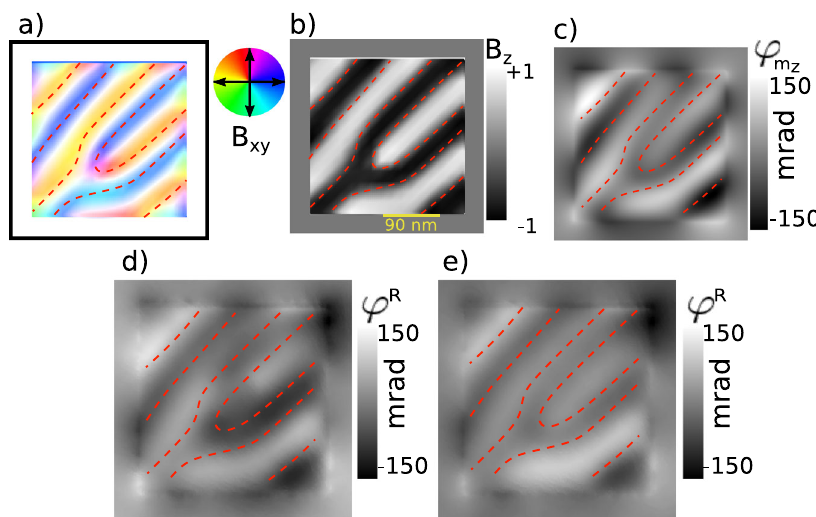
Fig. 4 Reconstruction of the phase shift resulting from the out-of-plane magnetic induction in a simulated sample with multiple domains. a The direction of in-plane magnetic induction, B xy , indicated by the color wheel. b Out-of-plane magnetic induction, B z , shown in gray-scale normalized to the magnetic saturation, indicated by the color bar. c Simulated magnetic phase shift due to the out-of-plane component of magnetization, φ m vortex beam (EVB) with orbital angular momentum (OAM) = ± 20; phase indicated by the color bars. d Phase shift reconstructed, φ R , for EVB with OAM = 20 obtained at a single defocus value. e Phase shift reconstructed for EVB with OAM = 20 obtained using both overfocused and underfocused